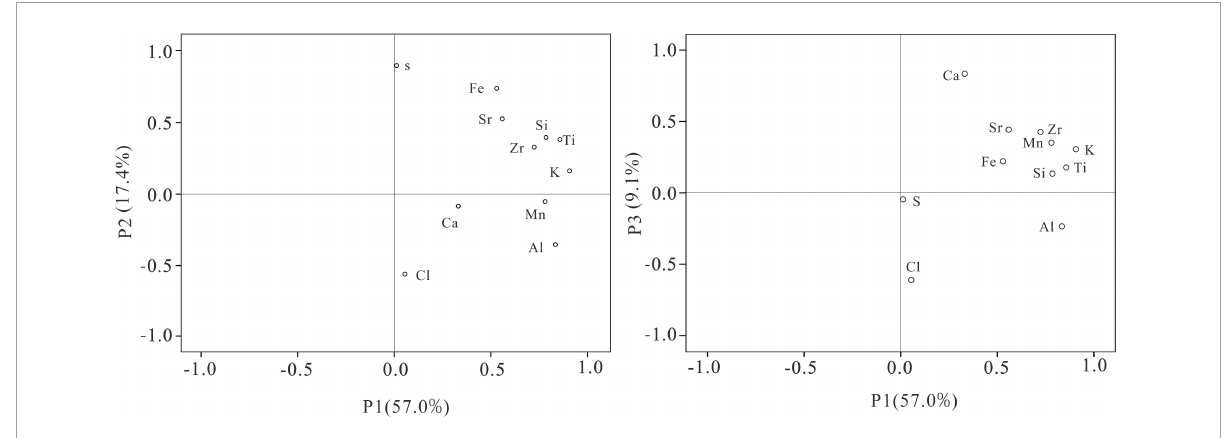
FIGURE4 Factor analysis component loads of elements in the GC core.